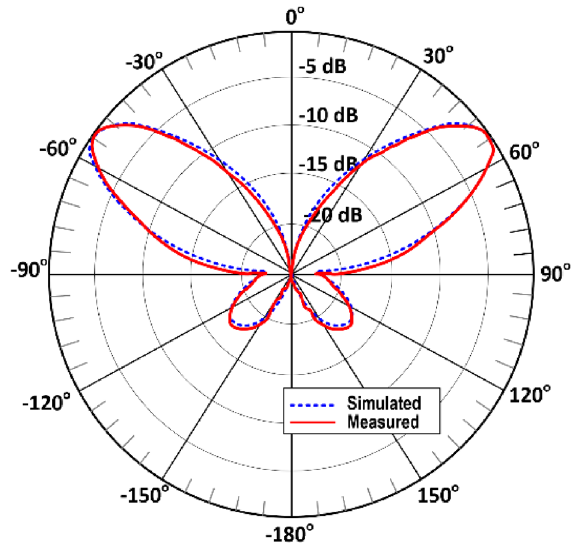
Figure 13. Normalized simulated and measured radiation pattern (E and H-planes) of the proposed 4-element antenna array at 4.25